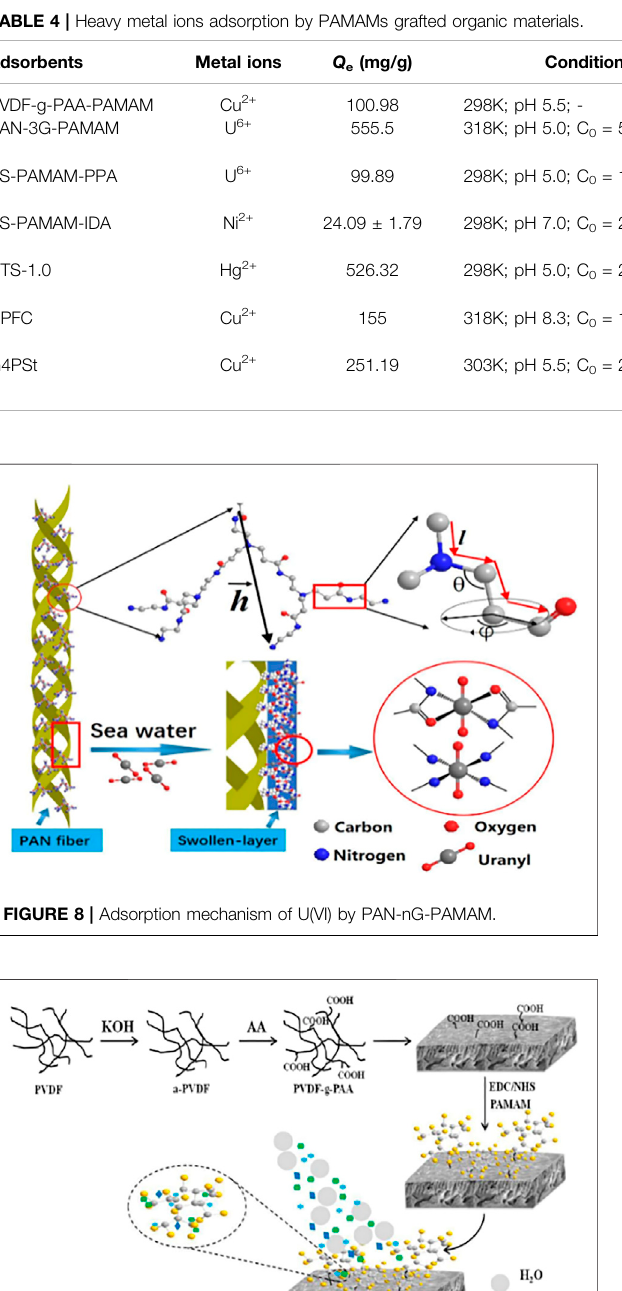
adsorbent reached 555.5 mg/g and the adsorption mechanism of U(VI) by PAN-nG-PAMAMs is shown in Figure 8 . The PAMAMs modi fi ed poly (styrene-co-divinylbenzene) (PS-PAMAM-PPA) was used to adsorb U(VI) from aqueous solution (Cao et al.,